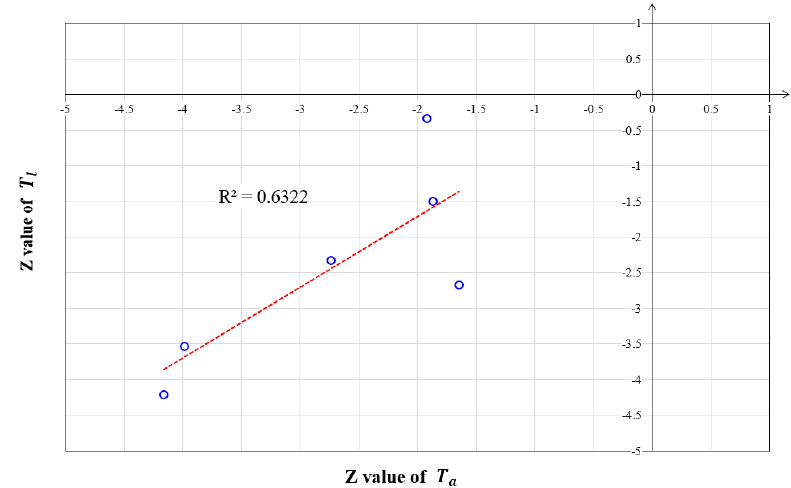
Figure 4. Linear correlation between Z values for tritium discharged in airborne and liquid e ffl uents from NPPs shown in Figure 3 except Rheinsberg, Greifswald-1,2,3,4, and 5, Muelheim-Kaerlich NPPs where either airborne or liquid effluent data is not available. The red line represents the resulting plots with a determinant R 2 of the estimated linear regression equation.